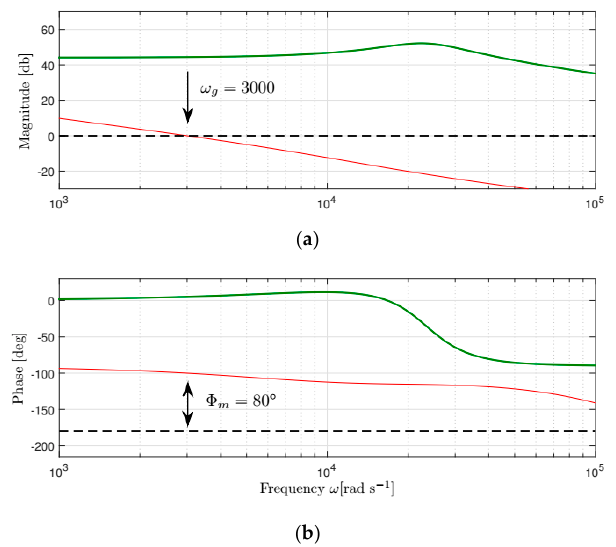
Figure 8. The Nyquist plot of the open-loop frequency response of the 3-leg interleaved buck converter with the proposed control. Energies 2020 , 13 , x FOR PEER REVIEW